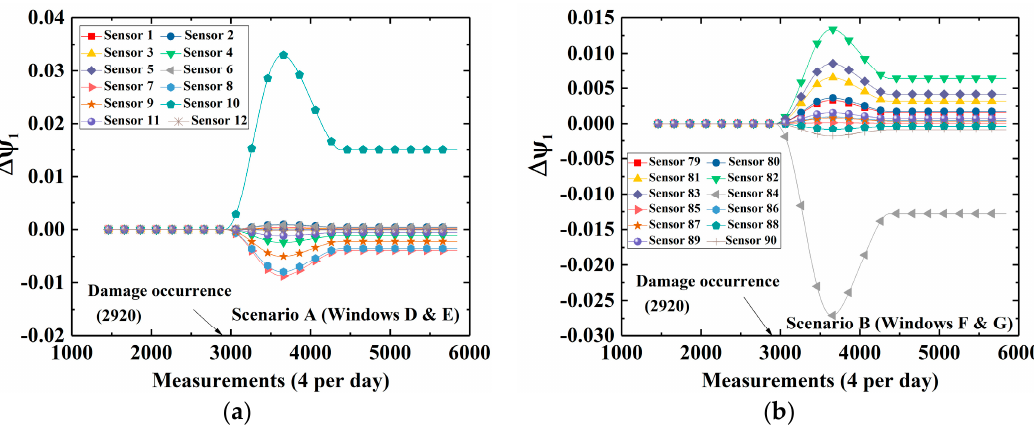
Figure 18. Time-variant CEVs with different space windows for Scenario A and B: ( a ) Windows D and E; ( b ) Windows F and G.